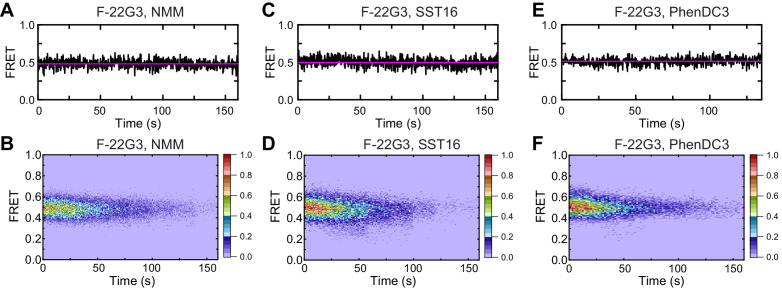
Effects of ligands on F-22G3 FRET.Representative FRET trajectories and heat maps of F-22G3 in the presence of NMM (A, B); 800 μM in folding reaction), SST16 (C, D); 5 μM) or PhenDC3 (E, F); 1 μM); n = 110 (B), n = 96 (D), n = 103 (F), collected in 2–3 independent experiments.